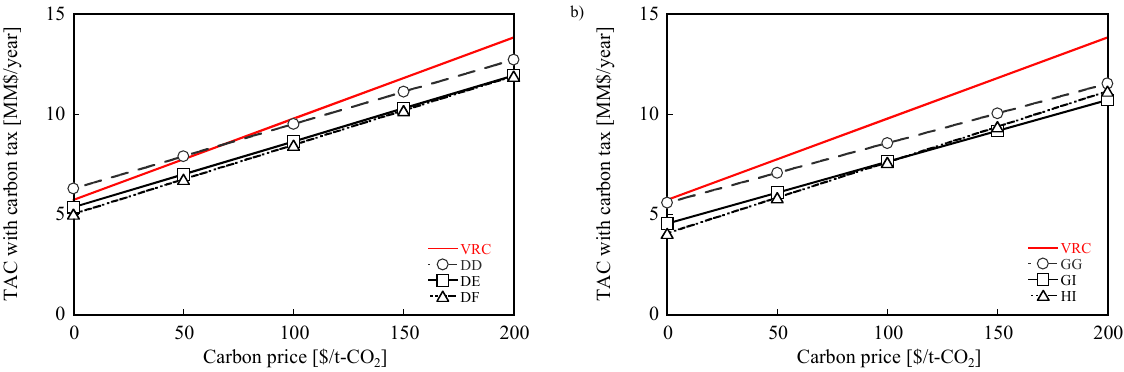
Figure 10. CO 2 emissions and TACs with carbon tax for: ( a ) DD, DE, and DF in Case 1, and ( b ) GG, GI, and HI in Case 2 .